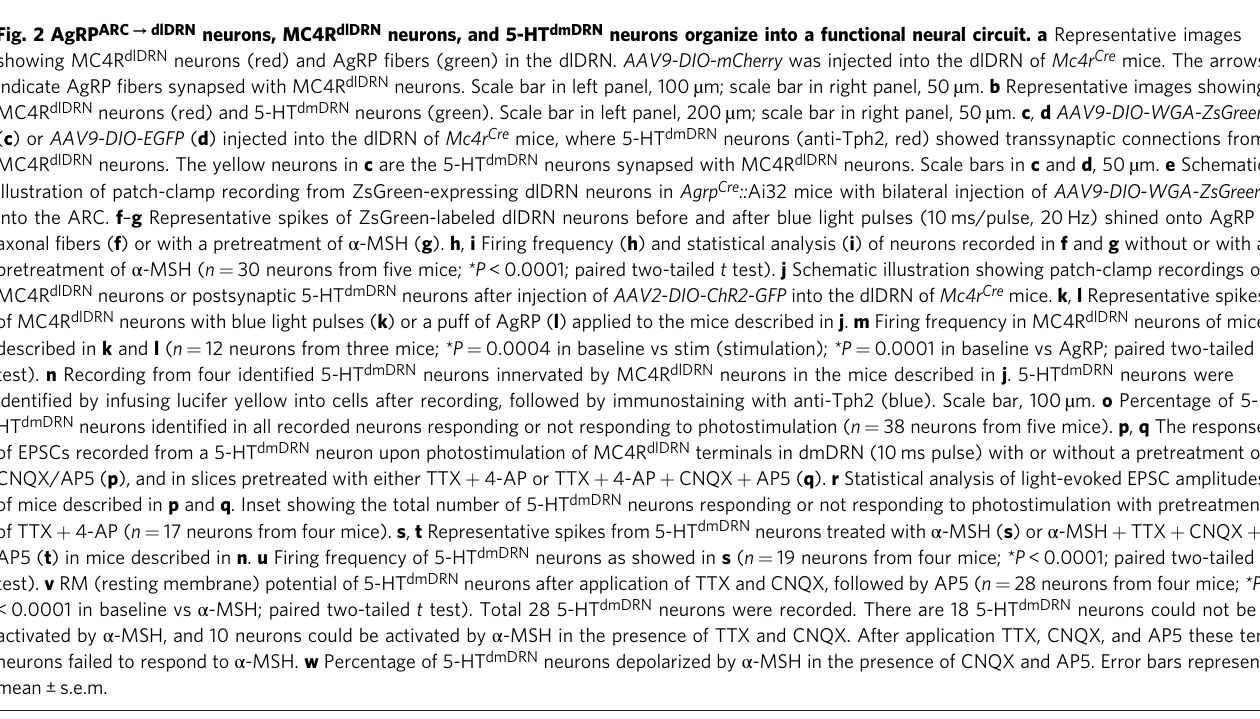
Fig. 2 AgRP ARC → dlDRN neurons, MC4R dlDRN neurons, and 5-HT dmDRN neurons organize into a functional neural circuit. a Representative images showing MC4R dlDRN neurons (red) and AgRP fi bers (green) in the dlDRN. AAV9-DIO-mCherry was injected into the dlDRN of Mc4r Cre mice. The arrows indicate AgRP fi bers synapsed with MC4R dlDRN neurons. Scale bar in left panel, 100 µ m; scale bar in right panel, 50 µ m. b Representative images showing MC4R dlDRN neurons (red) and 5-HT dmDRN neurons (green). Scale bar in left panel, 200 µ m; scale bar in right panel, 50 µ m. c , d AAV9-DIO-WGA-ZsGreen ( c ) or AAV9-DIO-EGFP ( d ) injected into the dlDRN of Mc4r Cre mice, where 5-HT dmDRN neurons (anti-Tph2, red) showed transsynaptic connections from MC4R dlDRN neurons. The yellow neurons in c are the 5-HT dmDRN neurons synapsed with MC4R dlDRN neurons. Scale bars in c and d , 50 µ m. e Schematic illustration of patch-clamp recording from ZsGreen-expressing dlDRN neurons in Agrp Cre :: Ai32 mice with bilateral injection of AAV9-DIO-WGA-ZsGreen into the ARC. f – g Representative spikes of ZsGreen-labeled dlDRN neurons before and after blue light pulses (10 ms/pulse, 20 Hz) shined onto AgRP axonal fi bers ( f ) or with a pretreatment of α -MSH ( g ). h , i Firing frequency ( h ) and statistical analysis ( i ) of neurons recorded in f and g without or with a pretreatment of α -MSH ( n = 30 neurons from fi ve mice; *P < 0.0001; paired two-tailed t test). j Schematic illustration showing patch-clamp recordings of MC4R dlDRN neurons or postsynaptic 5-HT dmDRN neurons after injection of AAV2-DIO-ChR2-GFP into the dlDRN of Mc4r Cre mice. k , l Representative spikes of MC4R dlDRN neurons with blue light pulses ( k ) or a puff of AgRP ( l ) applied to the mice described in j . m Firing frequency in MC4R dlDRN neurons of mice described in k and l ( n = 12 neurons from three mice; *P = 0.0004 in baseline vs stim (stimulation); *P = 0.0001 in baseline vs AgRP; paired two-tailed t test). n Recording from four identi fi ed 5-HT dmDRN neurons innervated by MC4R dlDRN neurons in the mice described in j . 5-HT dmDRN neurons were identi fi ed by infusing lucifer yellow into cells after recording, followed by immunostaining with anti-Tph2 (blue). Scale bar, 100 µ m. o Percentage of 5- HT dmDRN neurons identi fi ed in all recorded neurons responding or not responding to photostimulation ( n = 38 neurons from fi ve mice). p , q The response of EPSCs recorded from a 5-HT dmDRN neuron upon photostimulation of MC4R dlDRN terminals in dmDRN (10 ms pulse) with or without a pretreatment of CNQX/AP5 ( p ), and in slices pretreated with either TTX + 4-AP or TTX + 4-AP + CNQX + AP5 ( q ). r Statistical analysis of light-evoked EPSC amplitudes of mice described in p and q . Inset showing the total number of 5-HT dmDRN neurons responding or not responding to photostimulation with pretreatment of TTX + 4-AP ( n = 17 neurons from four mice). s , t Representative spikes from 5-HT dmDRN neurons treated with α -MSH ( s ) or α -MSH + TTX + CNQX + AP5 ( t ) in mice described in n . u Firing frequency of 5-HT dmDRN neurons as showed in s ( n = 19 neurons from four mice; *P < 0.0001; paired two-tailed t test). v RM (resting membrane) potential of 5-HT dmDRN neurons after application of TTX and CNQX, followed by AP5 ( n = 28 neurons from four mice; *P < 0.0001 in baseline vs α -MSH; paired two-tailed t test). Total 28 5-HT dmDRN neurons were recorded. There are 18 5-HT dmDRN neurons could not be activated by α -MSH, and 10 neurons could be activated by α -MSH in the presence of TTX and CNQX. After application TTX, CNQX, and AP5 these ten neurons failed to respond to α -MSH. w Percentage of 5-HT dmDRN neurons depolarized by α -MSH in the presence of CNQX and AP5. Error bars represent mean ±